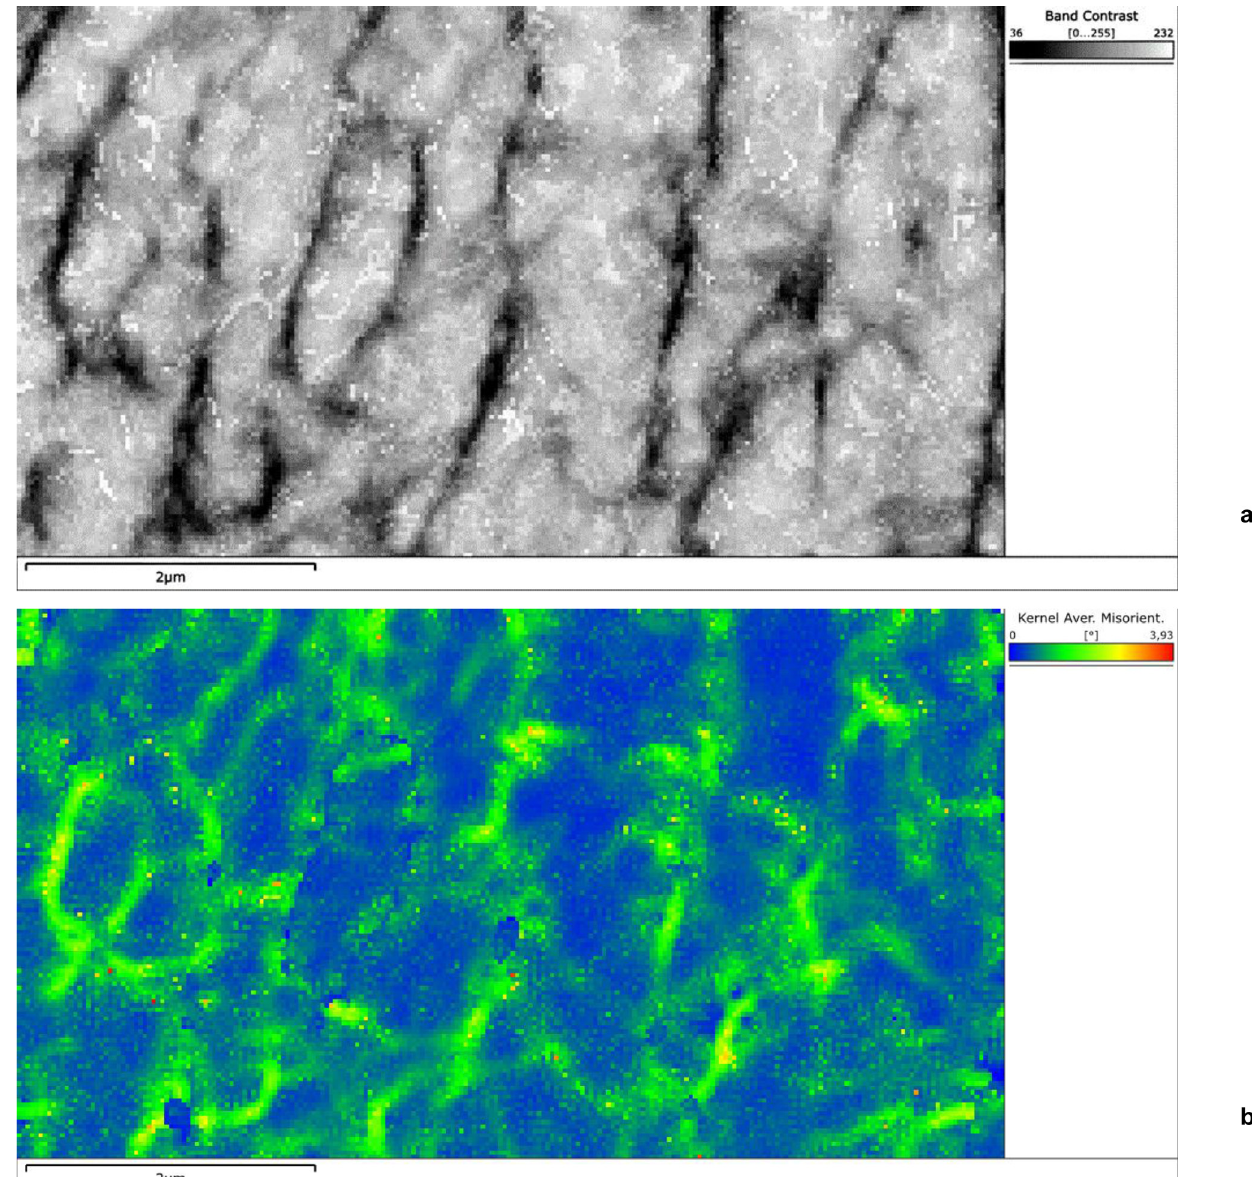
Fig. 14. HR EBSD map for the as-built temper. (a) Band contrast (cid:1) (b)